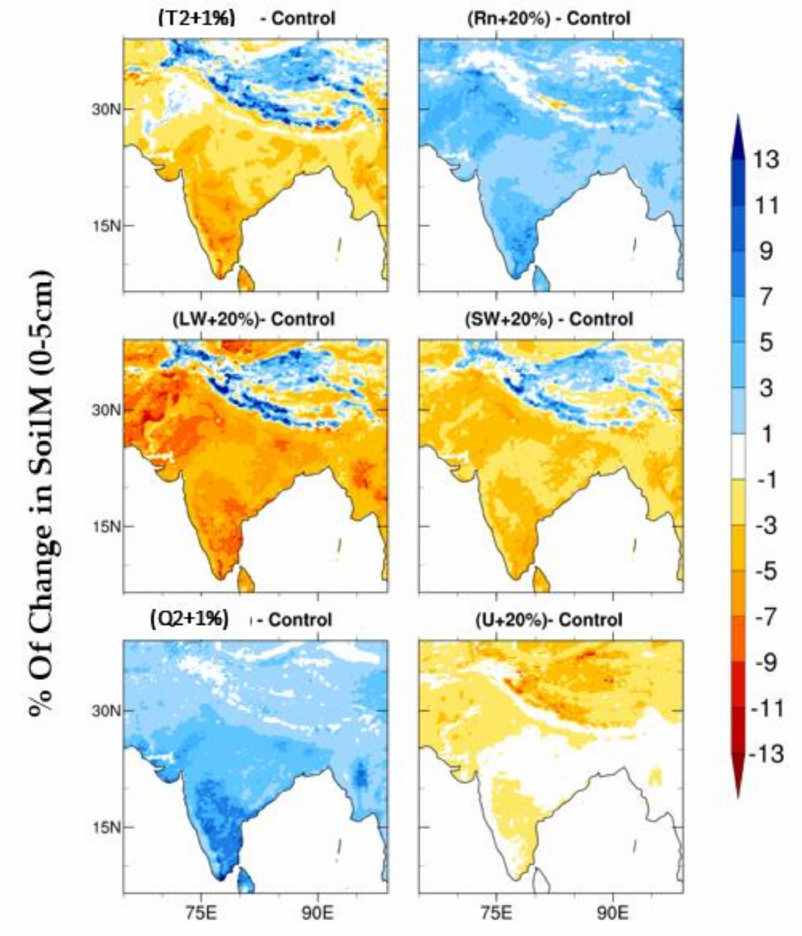
Figure 2. Annual soil moisture change (%) in each positive sensitive experiment compared to the control experiment during the year